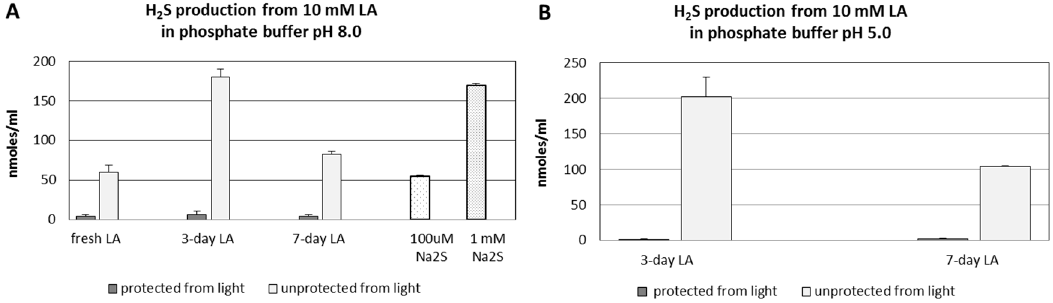
Figure 3. Level of H 2 S formed in vitro non-enzymatically from LA protected or non-protected from light detected by diffusion assay. In addition, 10 mM solution of LA in 50 mM phosphate buffer was used fresh as well as after three or seven days left in the presence or absence of environmental light. On the day of the experiment, the LA samples were pipetted into diffusion chambers and the level of H 2 S was detected after 90 min of diffusion. ( A ) the level of H 2 S formed at pH 8.0 from fresh LA, three-days LA and seven-days LA as well as from 100 μ M and 1 mM Na 2 S as the controls; and ( B ) the level of H 2 S formed at pH 5.0 from three-days LA and seven-days LA. The results are presented as the means ± SD from samples run in triplicate.